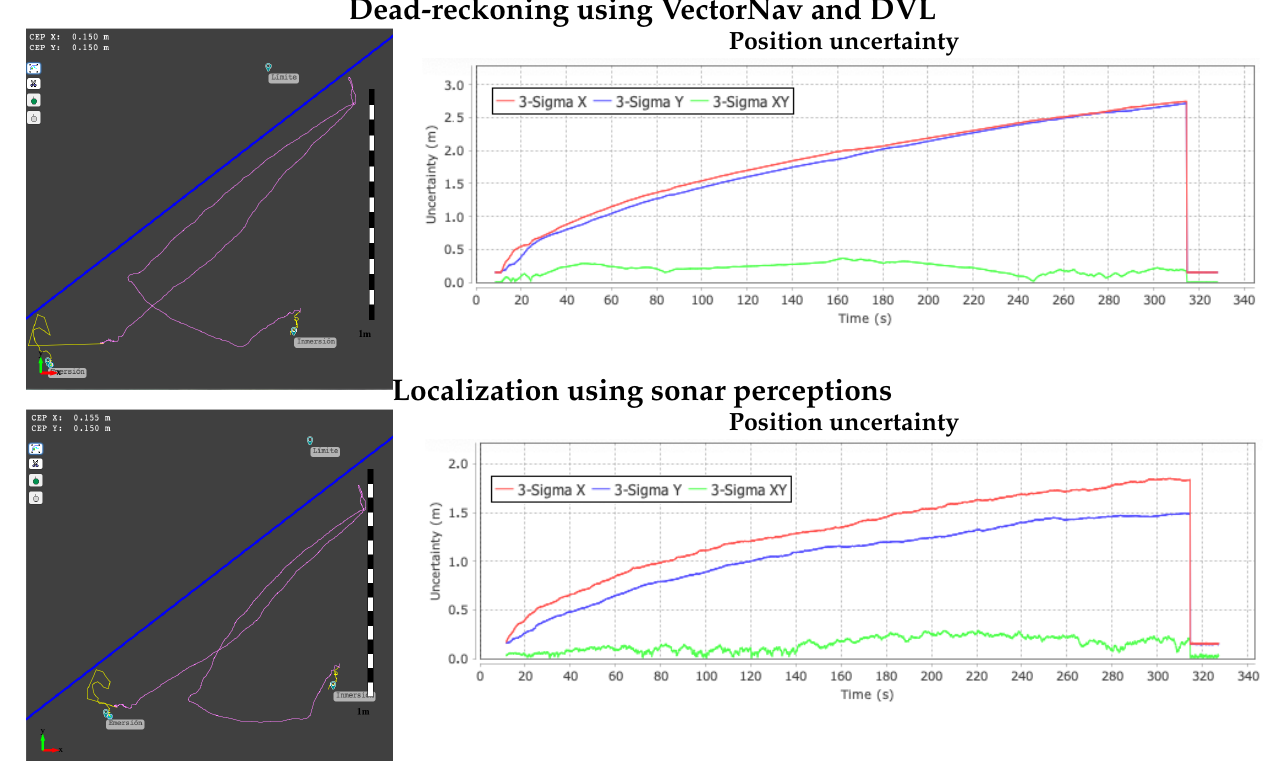
Figure 15. Position estimation uncertainty using ( top ) dead-reckoning and ( bottom ) particle-based localization system sensing uncertain line segments in the harbor